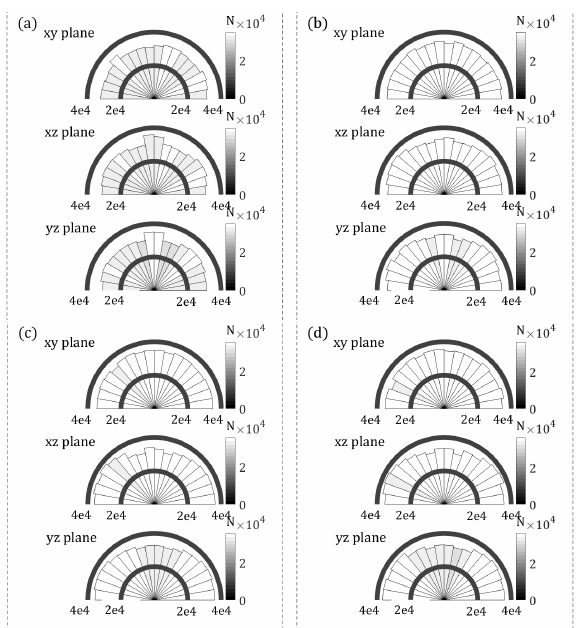
Figure 4. Contact distributions of the RM samples at p (cid:48) 1000 kPa , with projections onto the xy, xz and yz planes, respec- tively: (a) µ p = 0 . 05; (b) µ p = 0 . 25; (c) µ p = 0 . 50; and (d) µ p = 0 . 75.